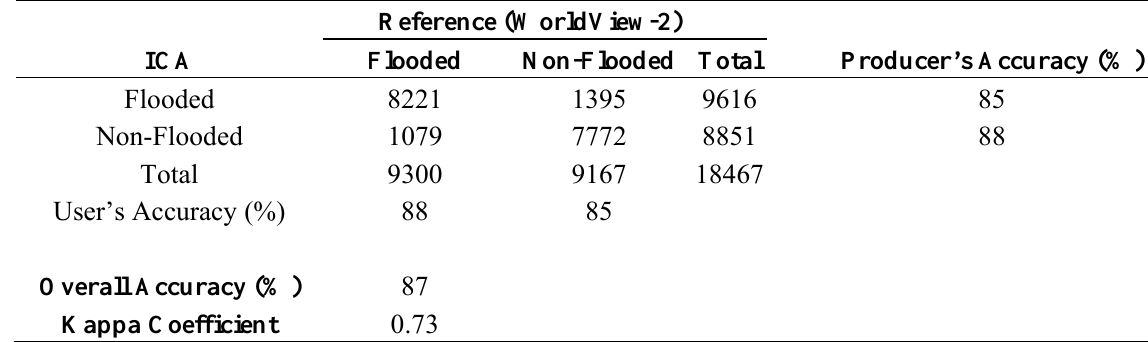
Figure 8. Map of Boulder Creek showing the results of the pixel-to-pixel comparison between the ICA modeled flood and the WV-2 reference layer. Pixels in agreement, errors of omission, and errors of commission are shown in contrasting colors. Table 1. Error matrix of the pixel-to-pixel validation between the ICA and WV-2 reference layer.